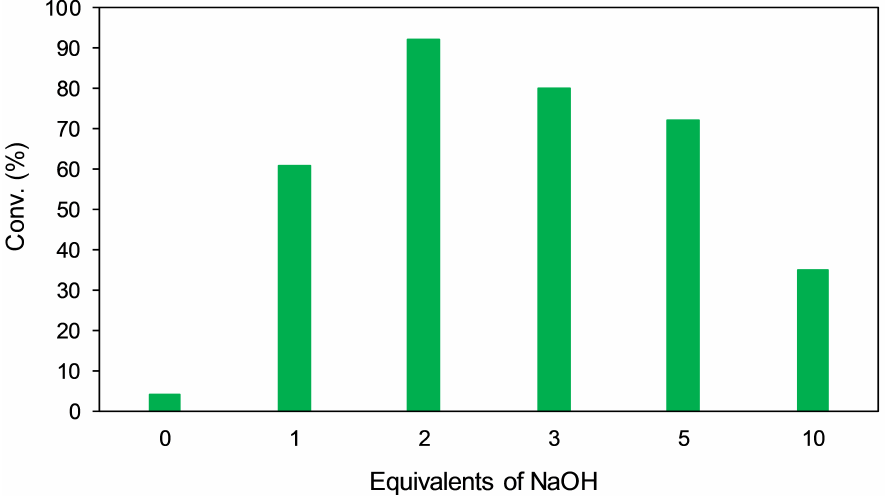
Figure 11. Effect of varying the amount of NaOH on the conversion of acetophenone. Little to no conversion of acetophenone was observed when employing weaker